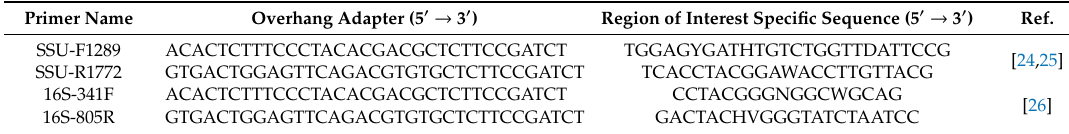
Table 1. PCR primers selected for metagenomic library preparation for first PCR reactions.